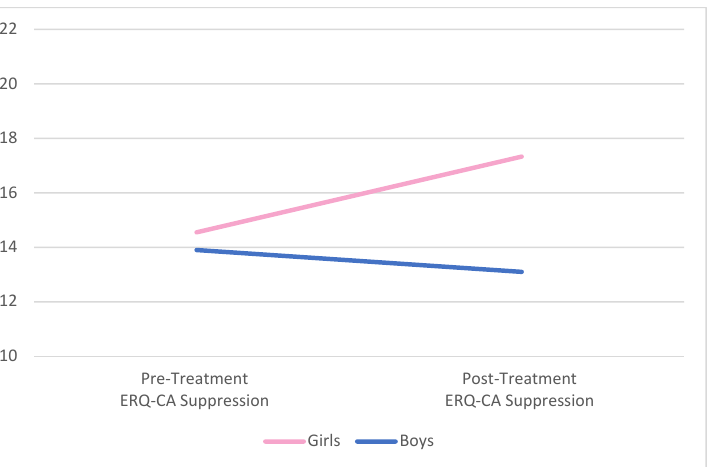
Figure 3. Pre- and post-treatment suppression by gender. Notes. No significant differences comparing pre-/post-treatment or comparing boys to girls. ERQ-CA = Emotion Regulation Questionnaire for Children and Adolescents.